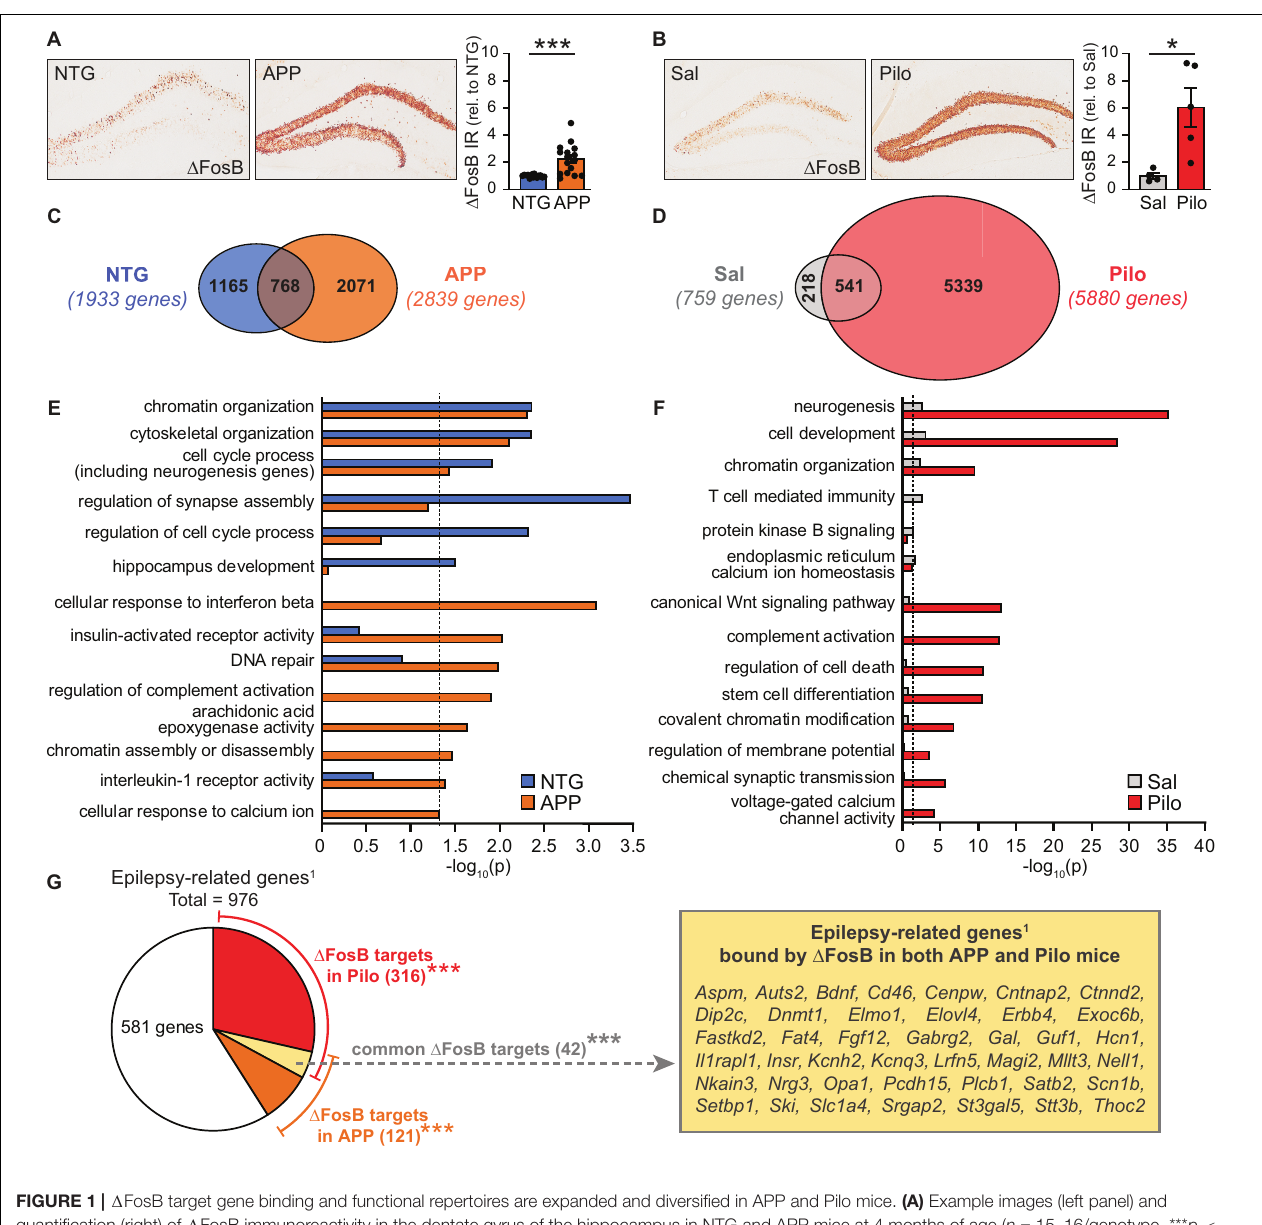
FIGURE 1 | (cid:49) FosB target gene binding and functional repertoires are expanded and diversified in APP and Pilo mice. (A) Example images (left panel) and quantification (right) of (cid:49) FosB immunoreactivity in the dentate gyrus of the hippocampus in NTG and APP mice at 4 months of age ( n = 15–16/genotype, *** p < 0.001 Student’s two-tailed unpaired t -test). (B) Example images (left panel) and quantification (right) of (cid:49) FosB immunoreactivity in the dentate gyrus of the hippocampus in Sal and Pilo mice 5 weeks post-treatment ( n = 4–5/group, * p < 0.05 Student’s two-tailed unpaired t -test). (C) Venn diagram representing the number of genes bound by (cid:49) FosB in NTG and APP mice. (D) Venn diagram representing the number of genes bound by (cid:49) FosB in Sal and Pilo mice. (E,F) Biological Process GO terms enriched by genes bound by (cid:49) FosB in NTG and APP mice (E) and in Sal and Pilo mice (F) . Dotted lines indicate p = 0.05 (two-sided hypergeometric tests with Benjamini-Hochberg correction). (G) Schematic depicting the number of epilepsy-related genes published in Wang et al. (2017), that are also bound by (cid:49) FosB in Pilo mice, APP mice, or both. *** p < 0.001 using hypergeometric test for overlap between known epilepsy-related genes 1 with the list of (cid:49) FosB target genes in Pilo mice, APP mice, or both. Call-out box lists the 42 genes bound by (cid:49) FosB in both APP and Pilo mice that were present in an Epilepsy-related genes database (Wang et al.,